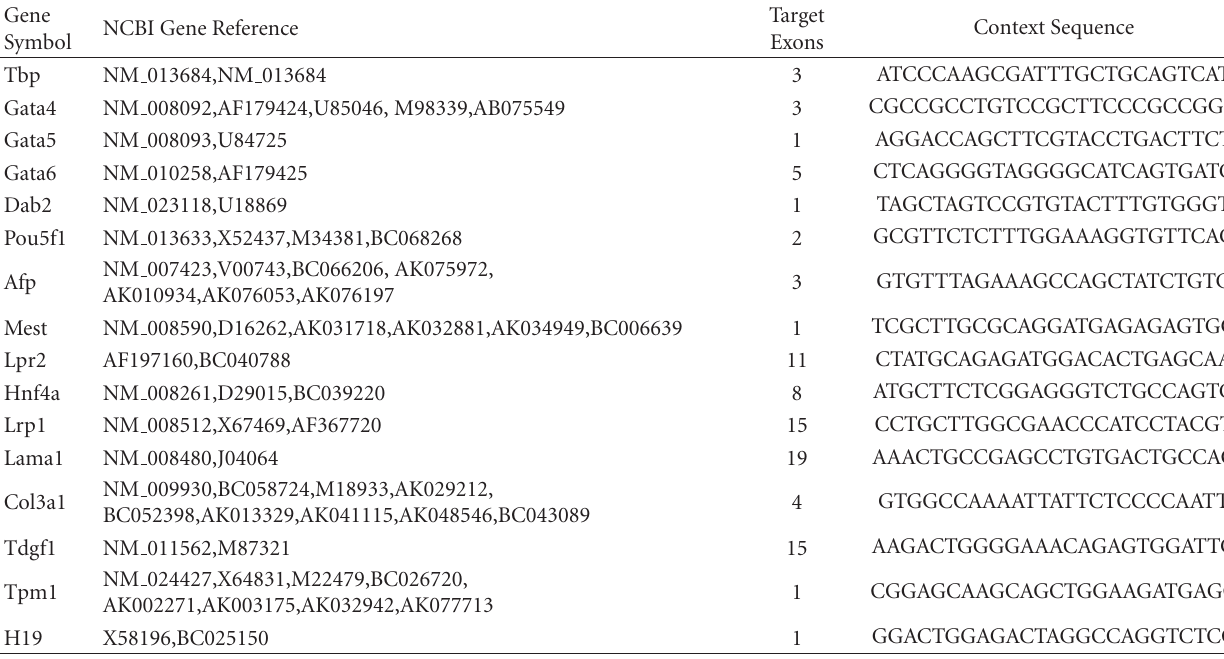
Table 1: Information on genes analyzed by real-time RT-PCR using Taqman